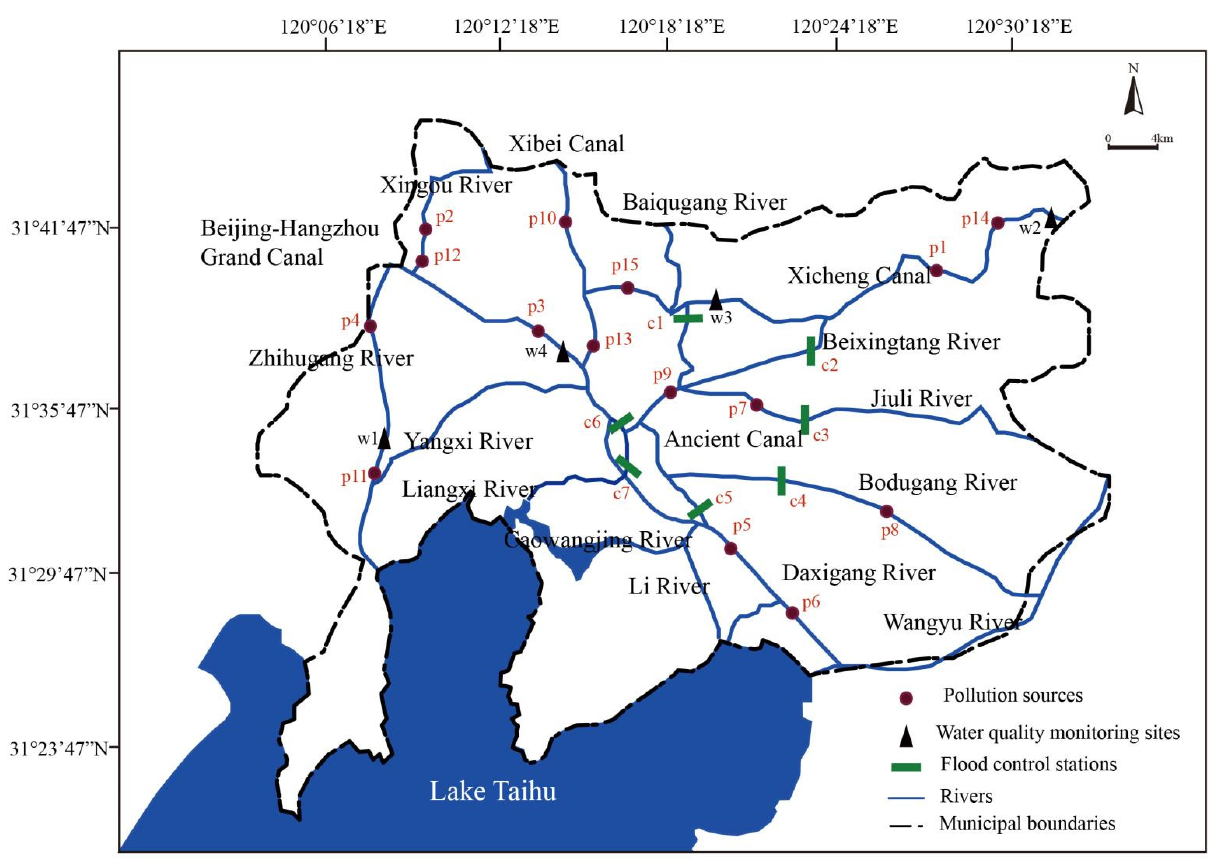
Figure 1. Research area and sampling points.